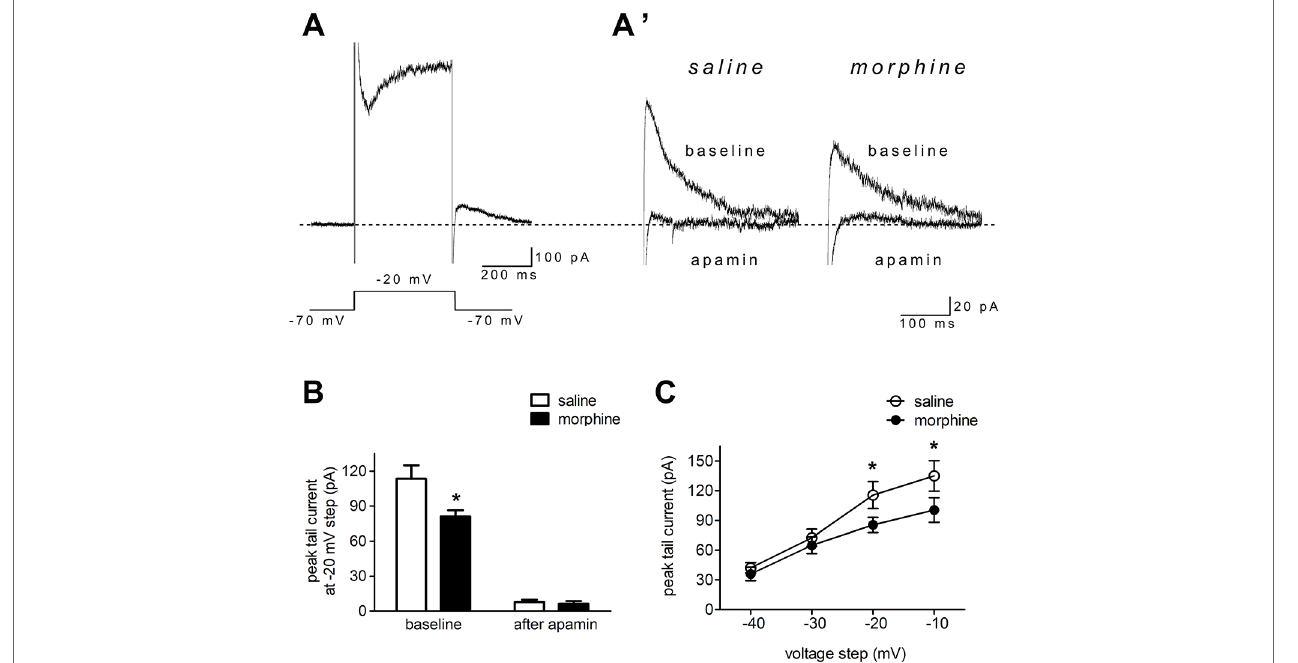
FIGURE 3 | Morphine withdrawal decreased SK currents in NAc shell neurons. (A) An example of an entire current response upon depolarization to –20 mV from a –70-mV holding potential in voltage clamp mode, with an apparent tail current after returning to –70 mV following the depolarization; (A’) magnified example tail currents. (B) Grouped data showing that peak tail currents were reduced in neurons from the morphine withdrawal group versus the saline mock treatment group. (C) Peak tail currents (induced by depolarization to –40 to –10 mV) were significantly different in neurons from the morphine withdrawal group than in those from the saline mock treatment group. The data are shown as means ± S.E.M., * p < 0.05 vs.